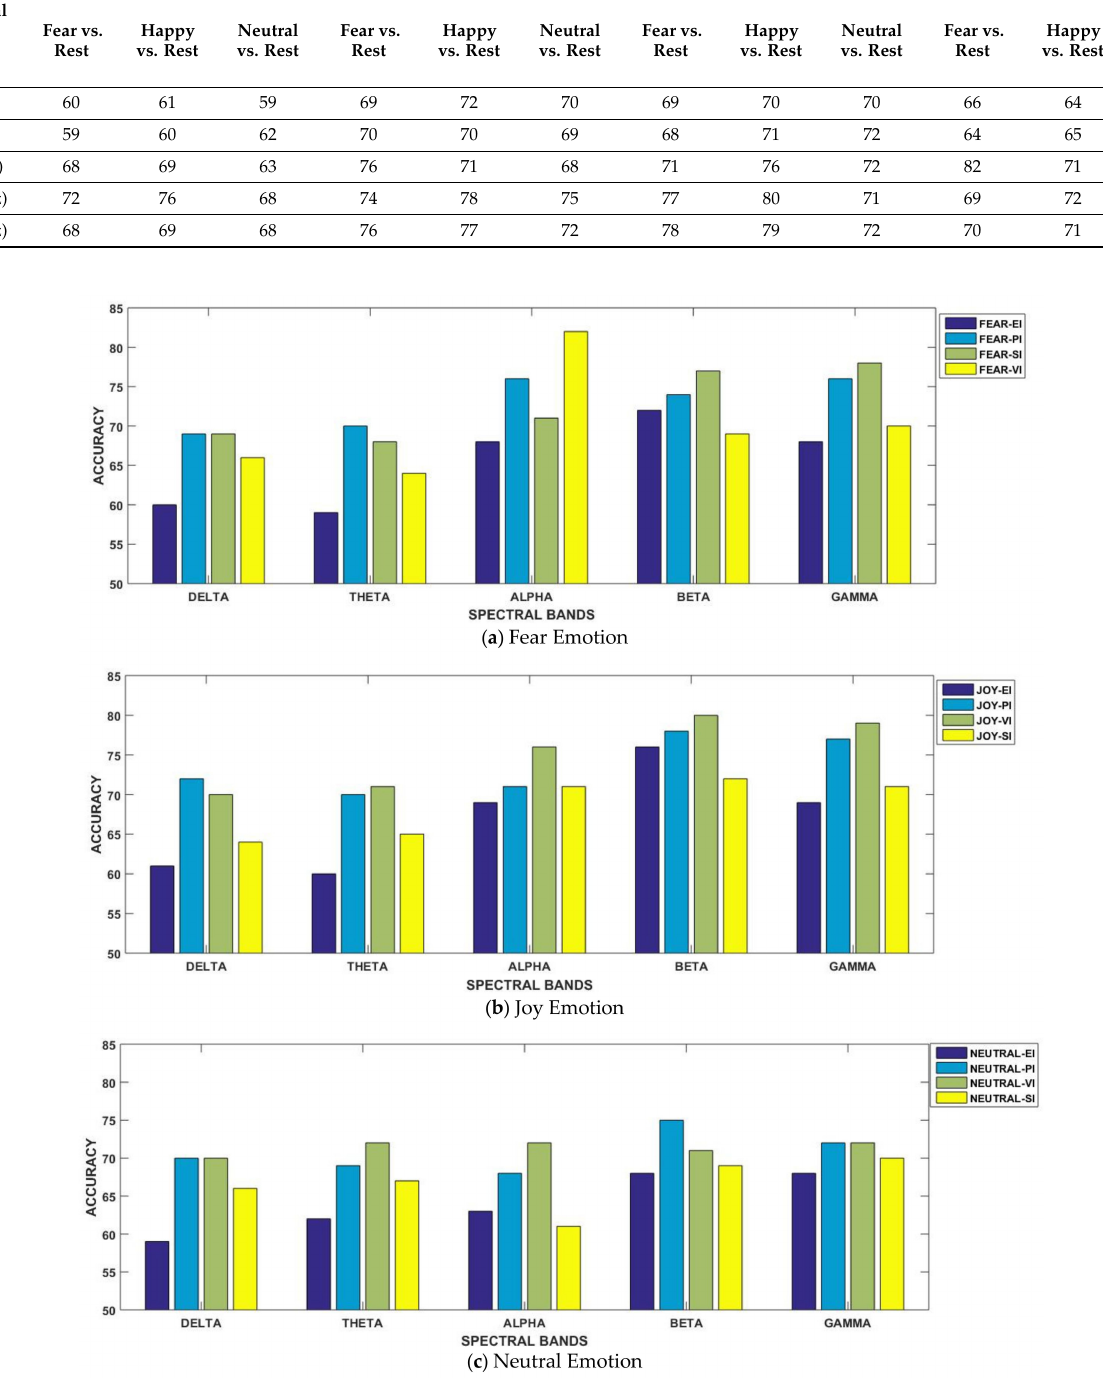
Figure 4. Comparison of classification accuracies amongst all emotion-evoking paradigms for all considered spectral